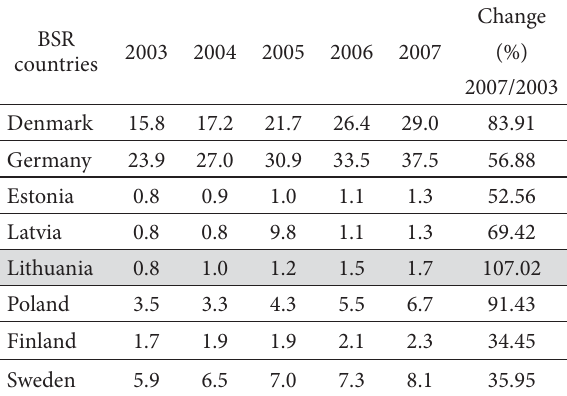
Table 2 . Th e dynamics of the export of transport services in BSR, mill. EUR (source: EUROSTAT) BSR countries